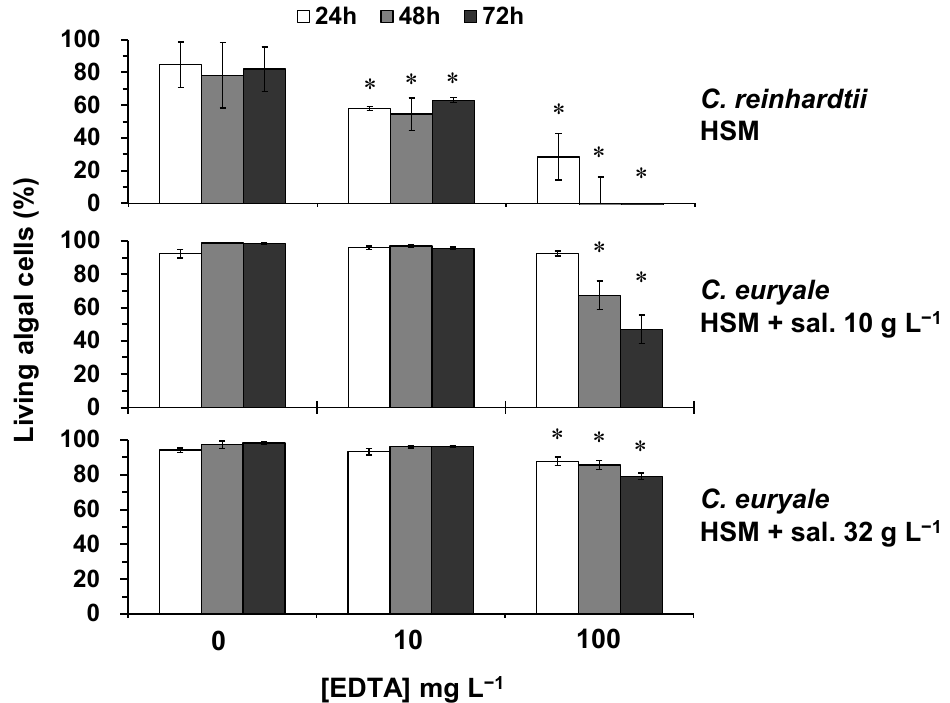
Figure 5. Living algal cells (%) at 24, 48, and 72 h of exposure to different concentrations of EDTA (0, 10 and 100 mg L − 1 ) for C. reinhardtii in HSM, and C. euryale in HSM under two salinity conditions, 10 g L − 1 and 32 g L − 1 . (*) Significant differences between the controls and treatments ( p < 0.05) were determined by one-way ANOVA and Tukey post-hoc test.